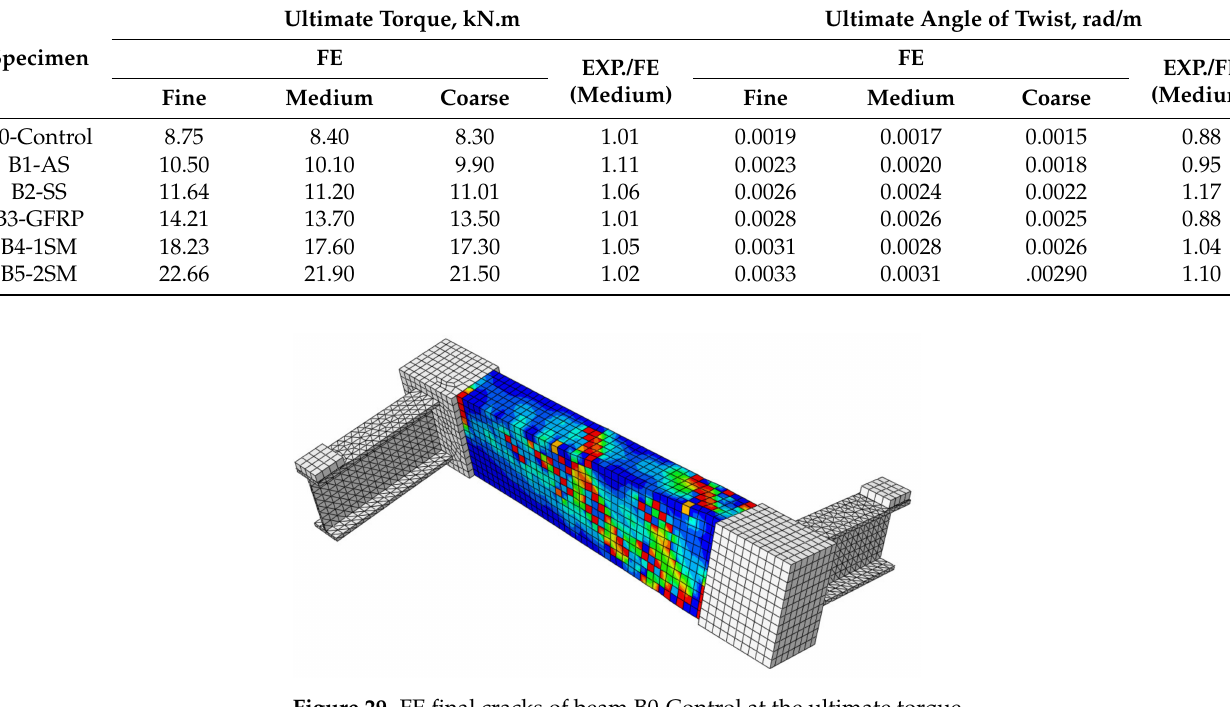
Figure 29. FE final cracks of beam B0-Control at the ultimate torque.